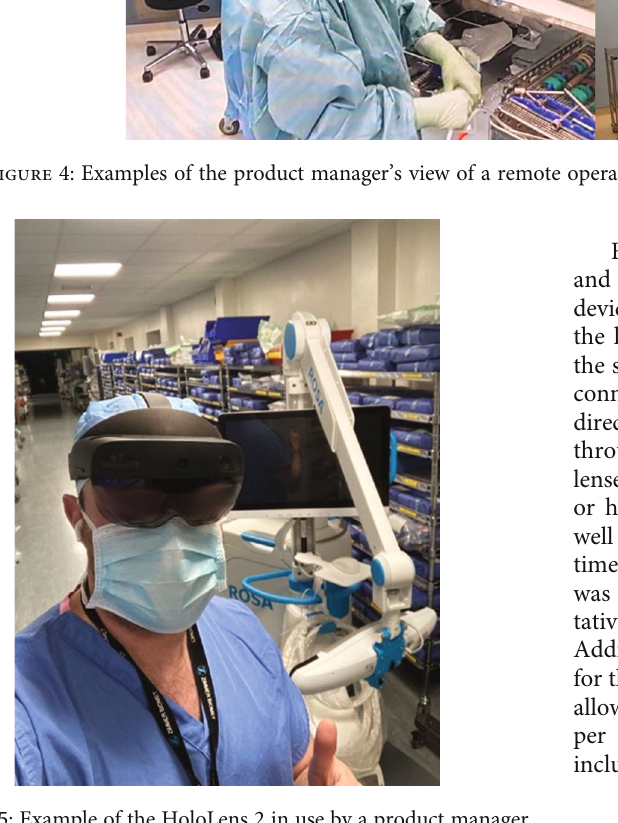
Figure 5: Example of the HoloLens 2 in use by a product manager at a distant